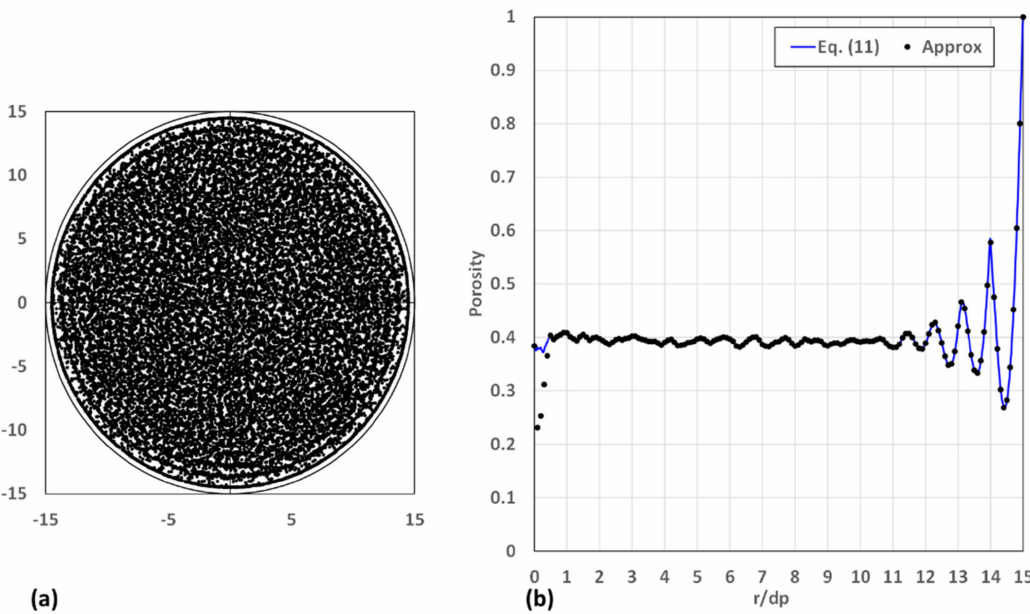
Figure 11. ( a ) Positions of centres of the spheres and ( b ) the radial variations in porosity based on Equation (11) and the approximate expression for D / d p =